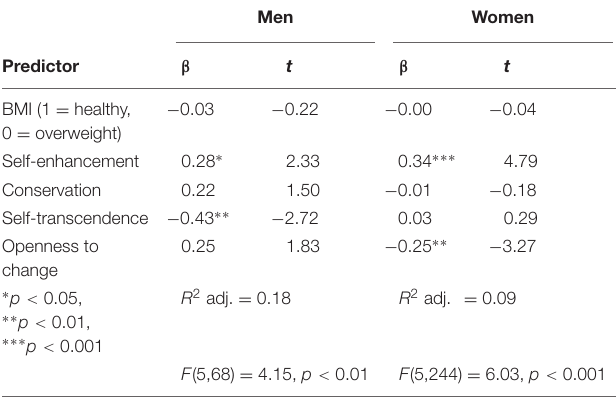
TABLE 4 | Multiple regression analysis predicting body